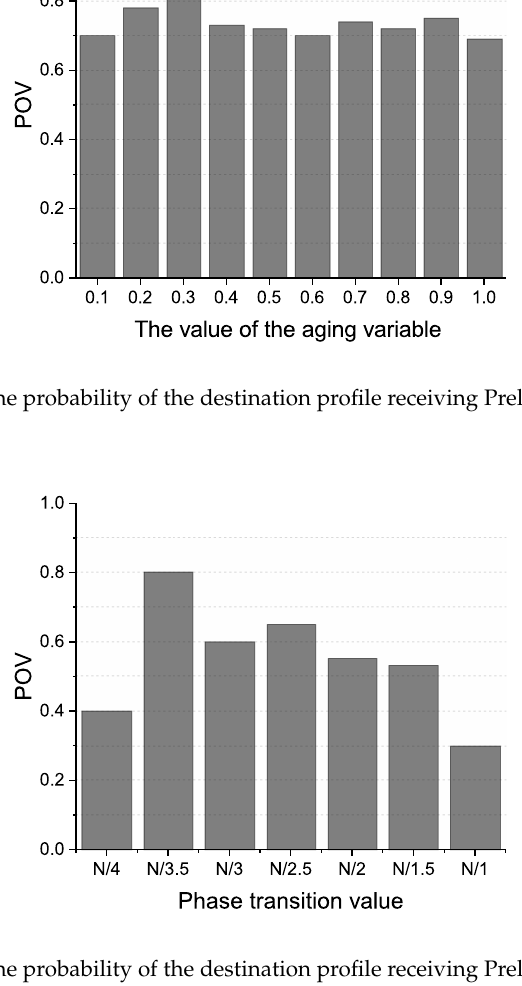
Figure 6. The probability of the destination profile receiving Prelearn